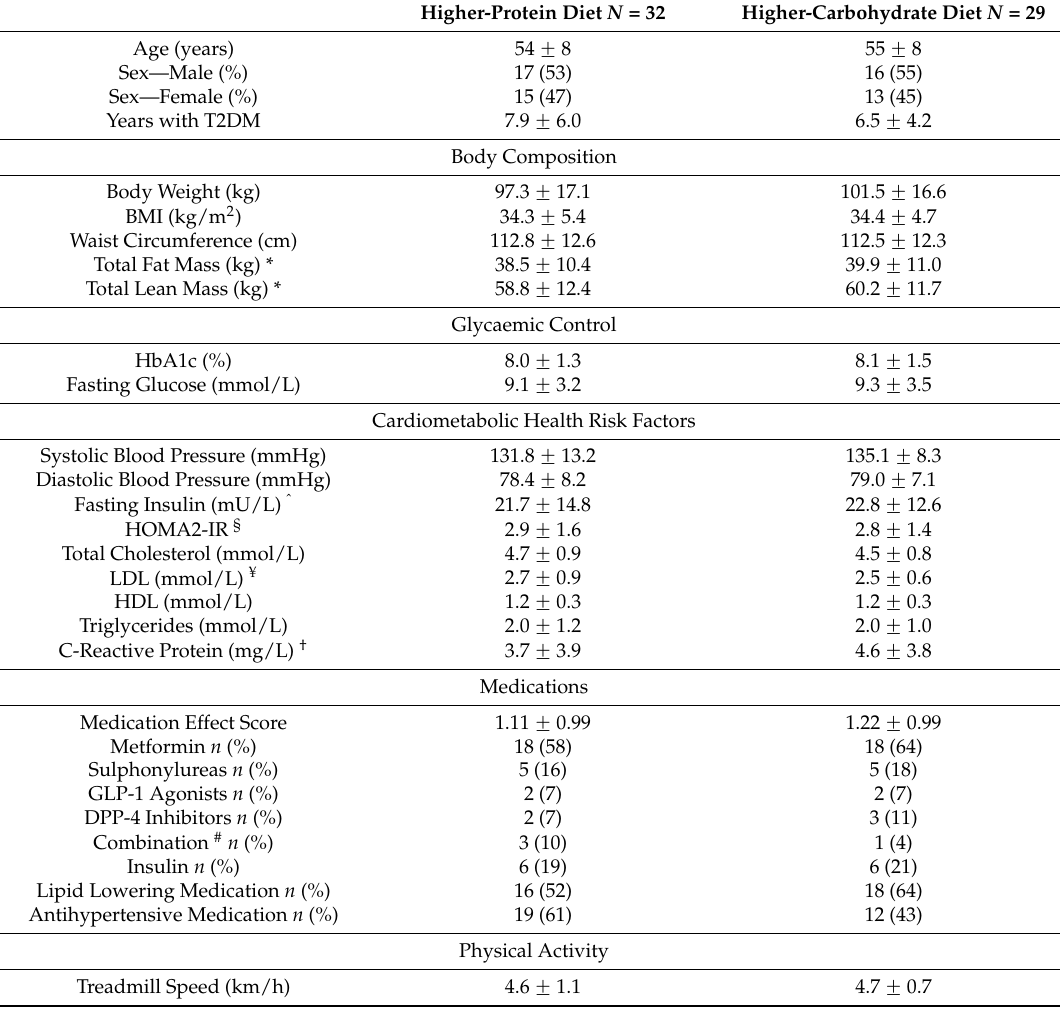
Table 1. Baseline characteristics for the study